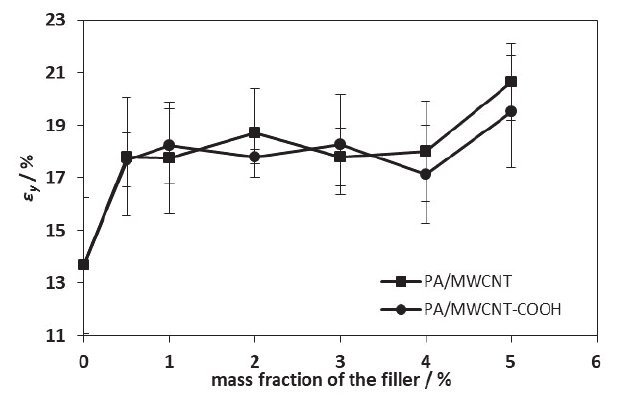
Fig. 13 – Influence of mass fraction of filler on yield strain of PA/MWCNT and PA/MWCNT-COOH nanocom-